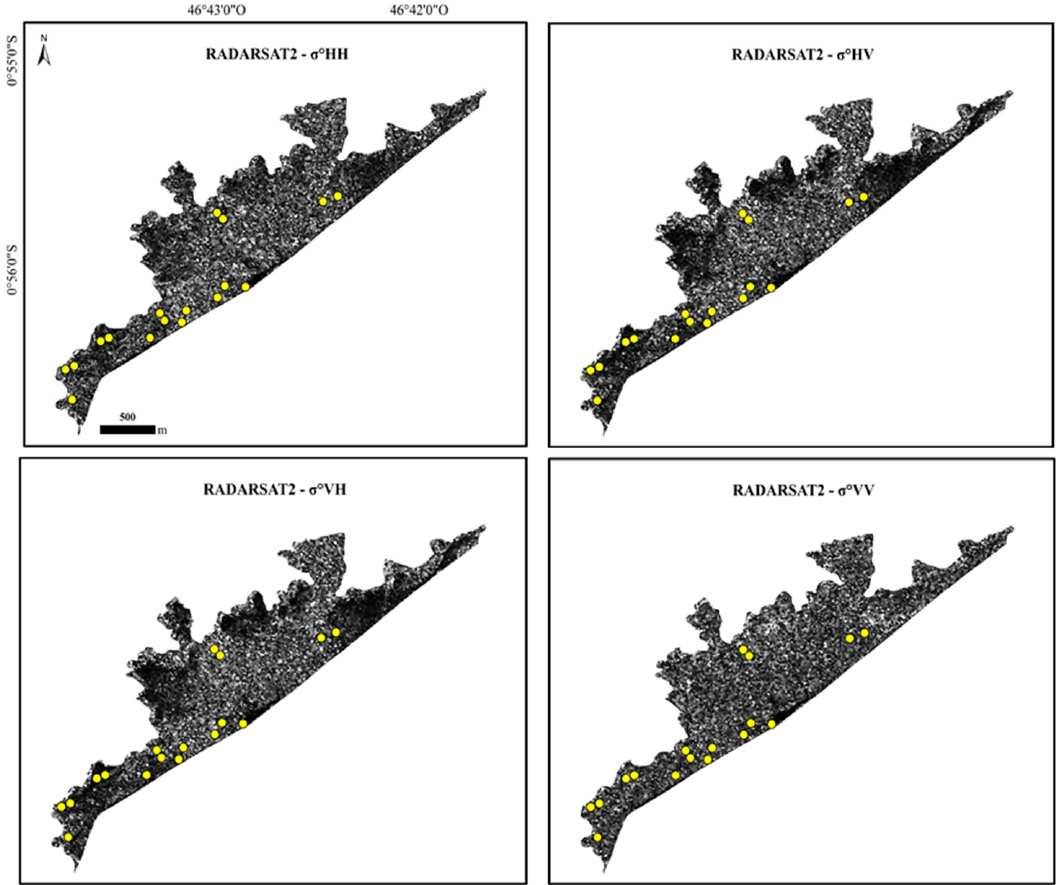
Figure 3. Radarsat-2 image in the four polarizations with the locations of the plots studied in the field.